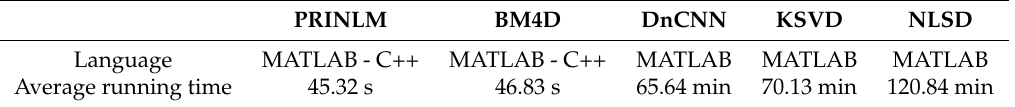
Table 4. Implementation language and computation time of the methods